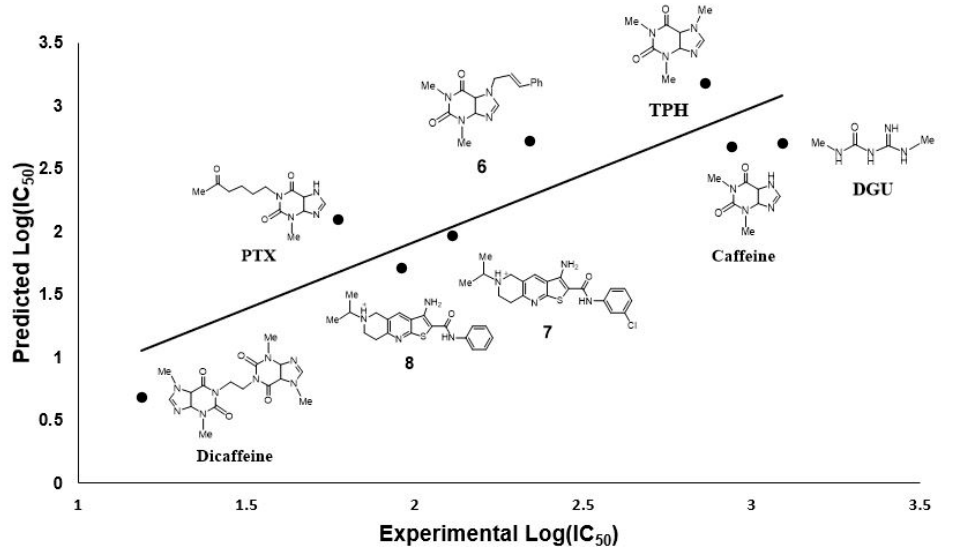
Figure 13. Inhibitors structures used for the model construction: caffeine (PDB: 2A3B), pentoxifylline (PTX; PDB: 2A3C), DGU (PDB: 3CH9), inhibitors 6 [15], 7 [22], 8 [22] and theophylline (TPH; PDB: 2A3A), and the linear relationship between IC 50pred and IC 50